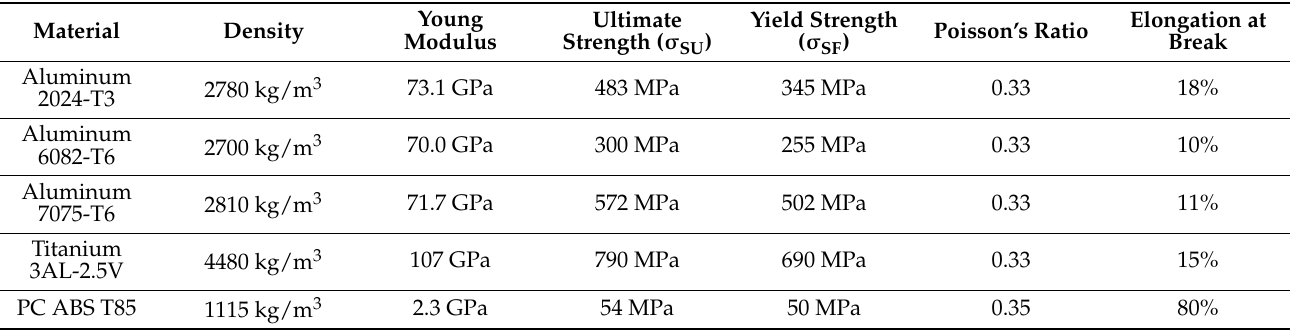
Table 4. Isotropic materials’ mechanical